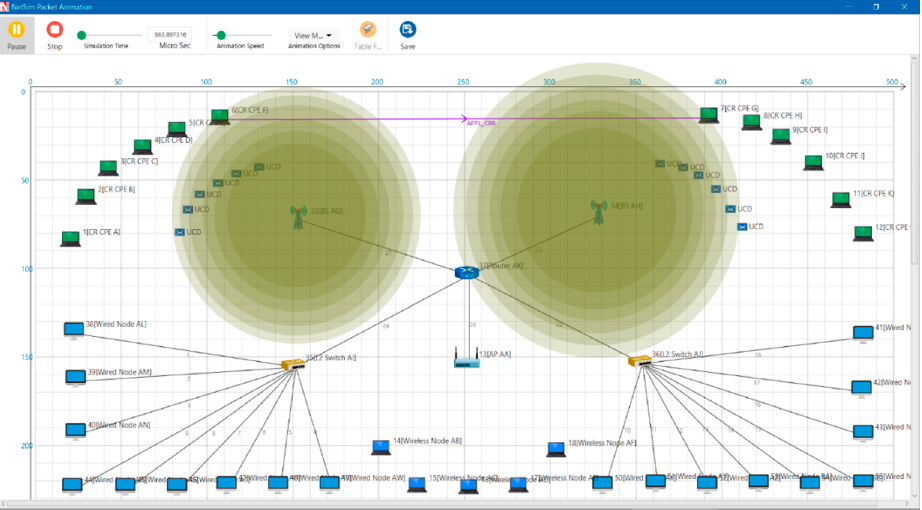
Table 1. Deployed parameters.